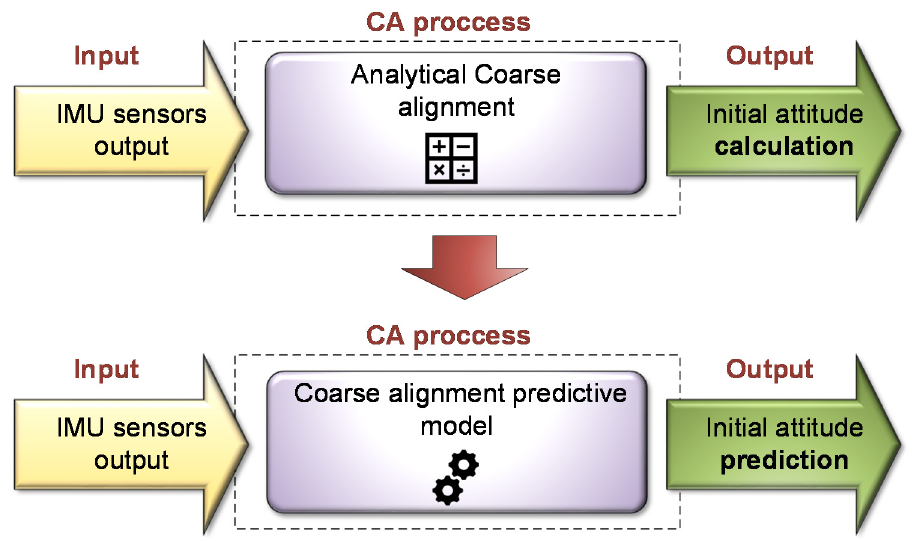
Figure 2. Proposed INS CA process using ML. Sensors 2020 , 20 , x FOR PEER REVIEW